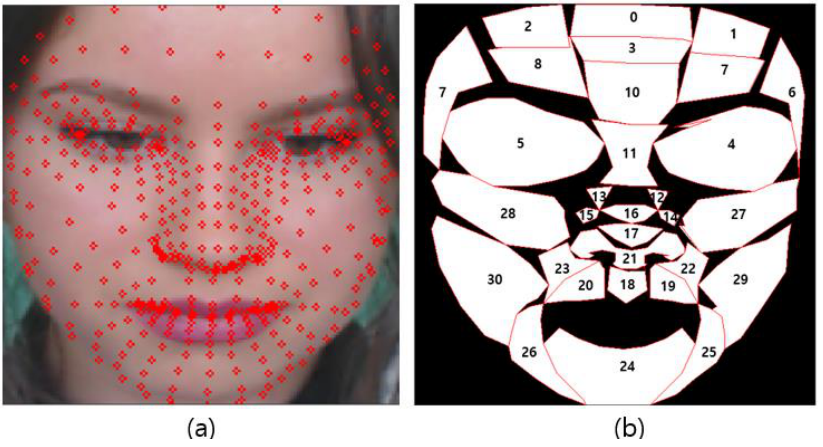
Figure 5. Proposed ROI list ( a ) face mesh image ( b ) ROI index.